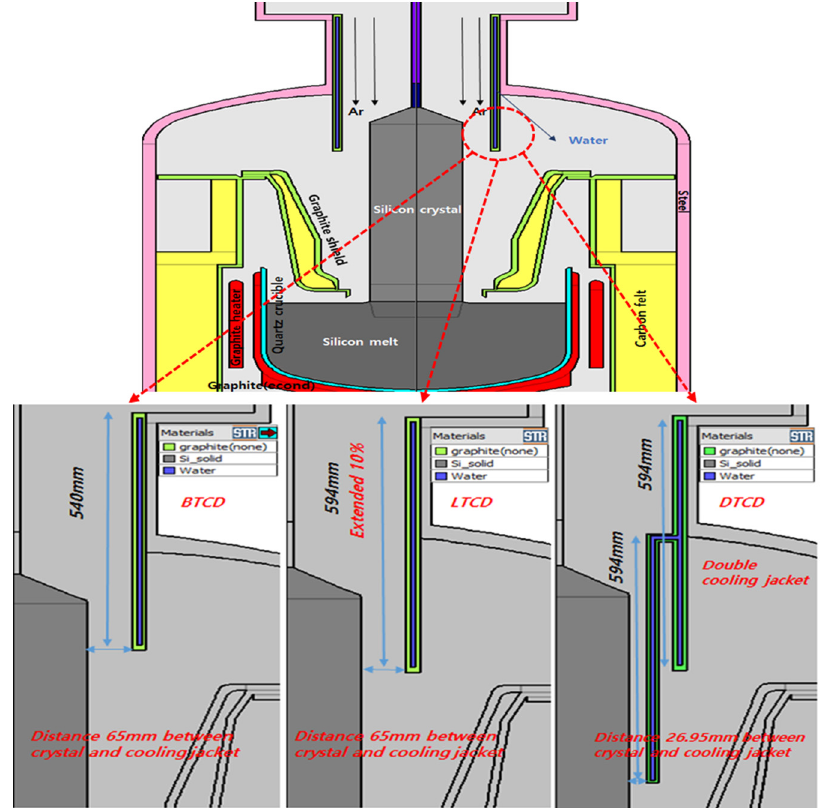
Figure 5. Modified cooling system in Czochralski process, basic cooling system to extended 10% long type cooling design and double type cooling design.